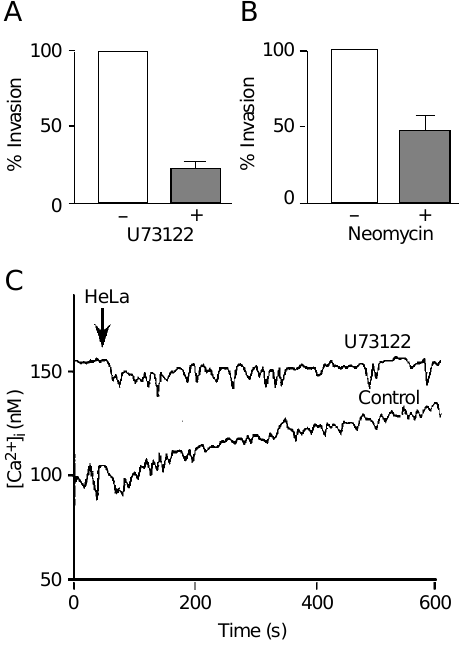
Figure 6 - Inhibition of HeLa cell invasion and Ca 2+ response by treatment of T. cruzi metacyclic trypomastigotes with phospho- lipase C inhibitor. Parasites were treated or not with: A , 10 µM U73122 for 4 min at 37 o C,